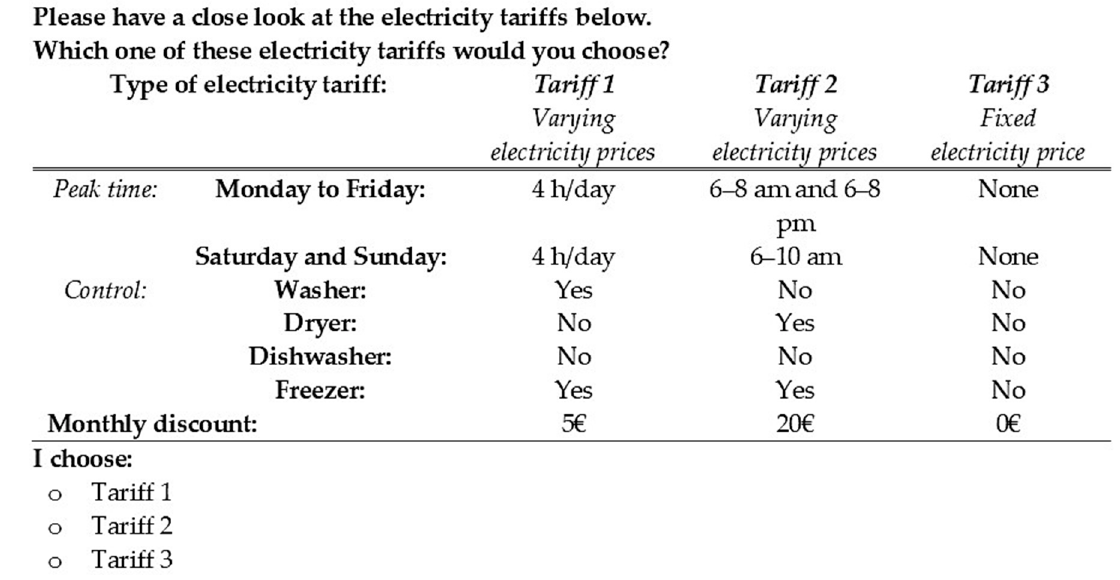
Figure 1. Translated choice set. Tariff 3 was introduced as status quo.